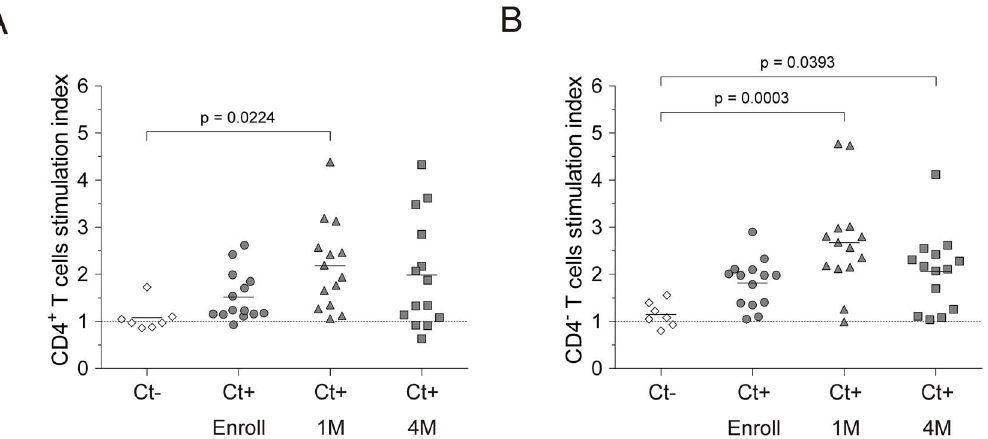
Figure 2. The ability of peripheral T cells from women with existing or treated Chlamydia infection to proliferate in response to stimulation with C.trachomatis elementary bodies (EB) decreased 4 months after antimicrobial administration. Peripheral blood mononuclear cells (PBMC) isolated from women at enrollment and at 1 and 4 m follow-up visits were cultured 96 h in presence of inactivated EB or media alone. Proliferation of (A) CD3 + CD4 + and (B) CD3 + CD4 - cells was assessed by flow cytometry using stimulation indexes calculated as described in Methods section. Stratification of Chlamydia -infected women by time since diagnosis and treatment of infection showed T cell proliferation was higher 1 month after treatment compared to enrollment, and that proliferative capacity diminished 4 months after treatment. Stimulation indexes of samples from Chlamydia -infected women (n=14) at indicated visits were compared to those from women with no known history of infection (n=7) using one-way ANOVA and Dunnett’s multiple comparison test (horizontal bars indicate